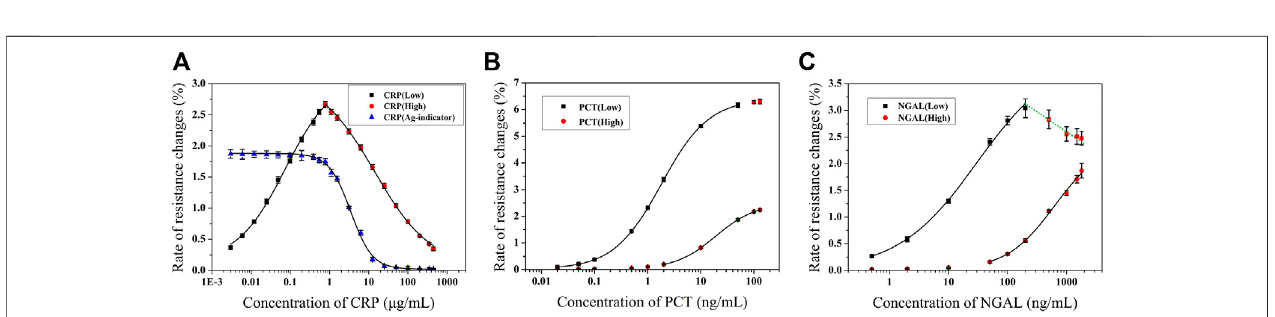
FIGURE7| StandardcurvesforCRP (A) (Adaptedwithpermissionfrom(Mengetal.,2021a)Copyright © 2021FandaMeng,etc.PublishedbyAmericanChemical Society), PCT (B), and NGAL (C) detection ( n = 4).